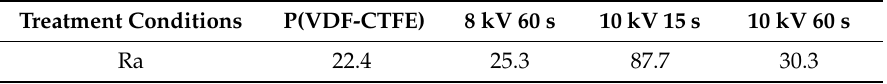
Figure 7. The surface morphology and roughness characterized by Atomic Force Microscope (AFM). ( a ) Untreated P(VDF ‐ CTFE) film. ( b ) The film treated at 8 kV for 60 s. ( c ) The film treated at 10 kV for 15 s. ( d ) The film treated at 10 kV for 60 s. Table 3. The surface roughness (Ra) of P(VDF ‐ CTFE) and films treated by DBD. (Unit: nm). Treatment